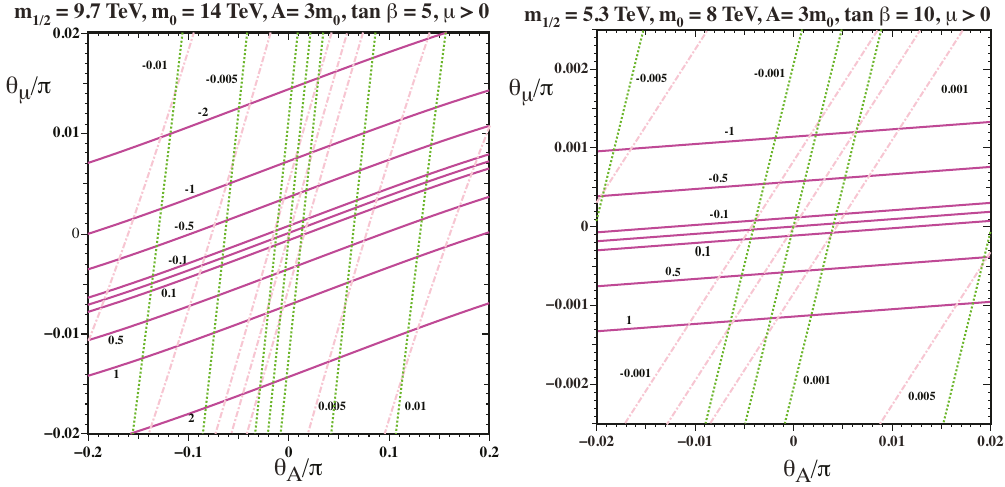
Figure 6 . Contours of the e (solid magenta), p (dotted pink), and n (dot dashed green) EDMs (relative to the experimental limits) in the ( θ µ , θ A plane for fixed m 1 For d n the ratio shown is with respect to 10 − 3 times the experimental limit and for d p with respect to 10 − 29 e cm . For case C, the unlabeled lines for d n and d p are · of the EDMs is 0 in both cases C and